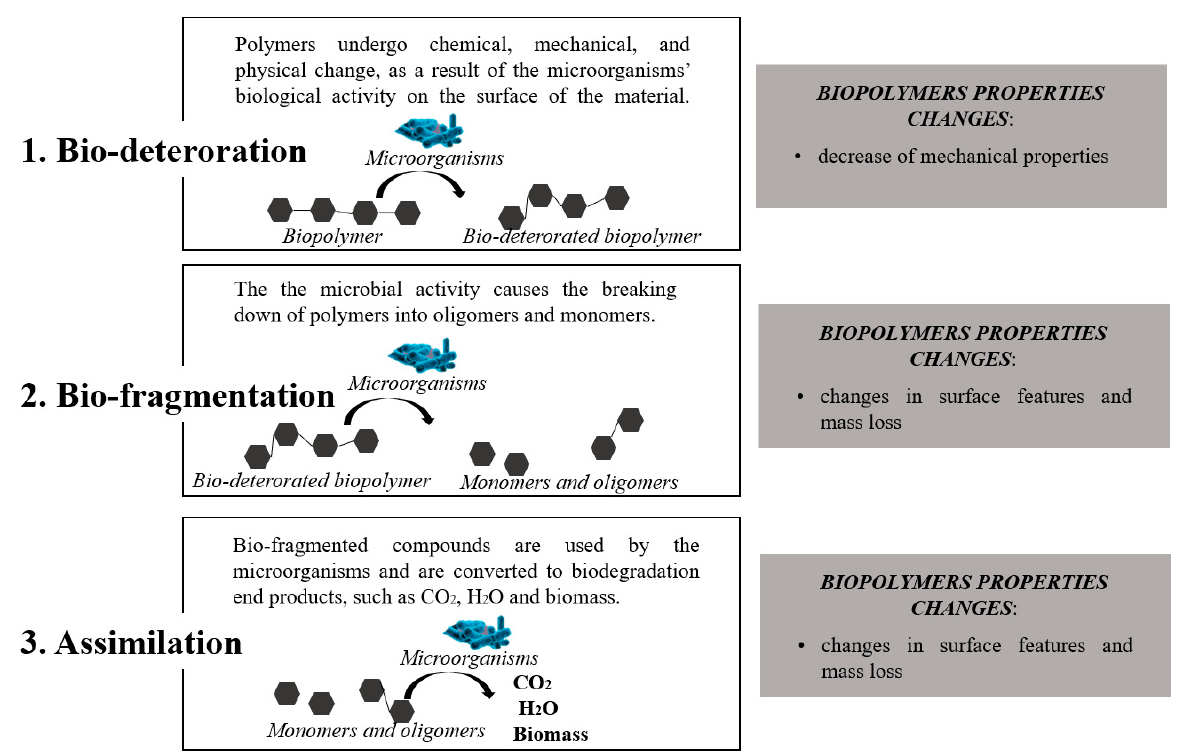
Figure 2. The main three steps through which the biodegradation of polymers occurs: (1) bio-deterioration, (2) bio-fragmentation, and (3) assimilation.